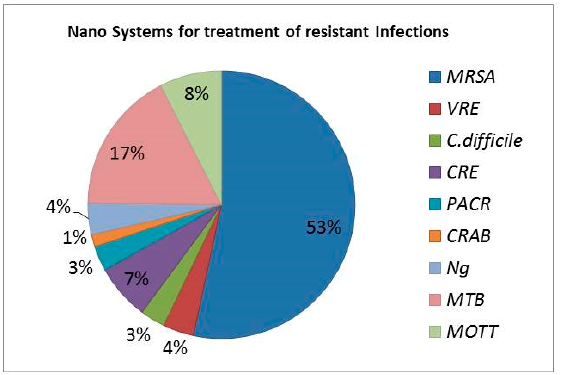
Figure 4. Distribution of nanosystems reported for resistant infection treatment per pathogen.